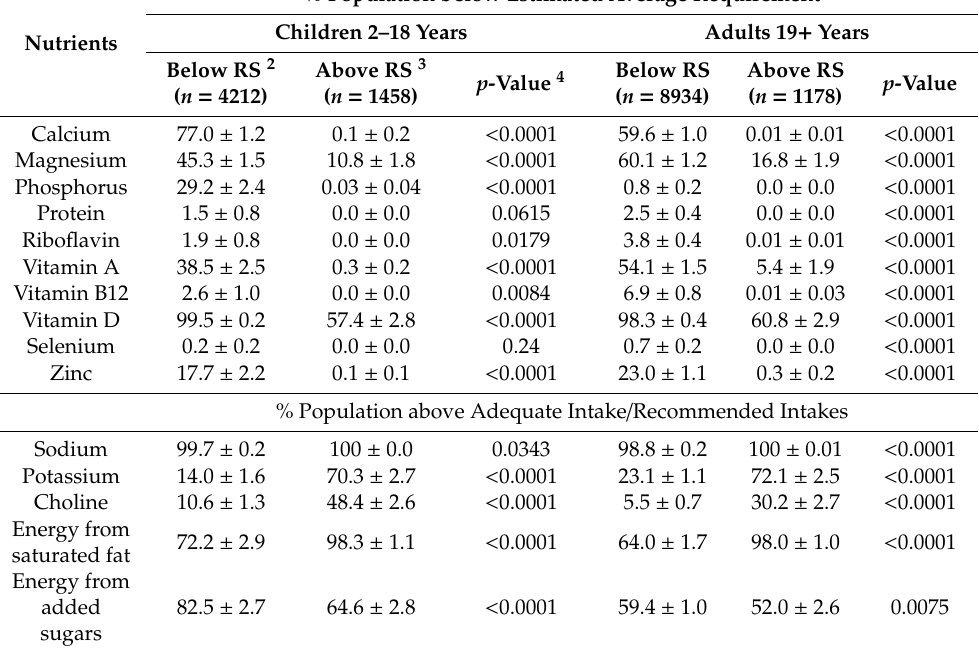
Table 5. Percent U.S. population (by age group) below the Estimated Average Requirement or Above Adequate Intake among those consuming above recommended daily servings of dairy (Above RS) and below recommended daily servings of dairy (Below RS), in the National Health and Nutrition Examination Survey 2013–2016 1